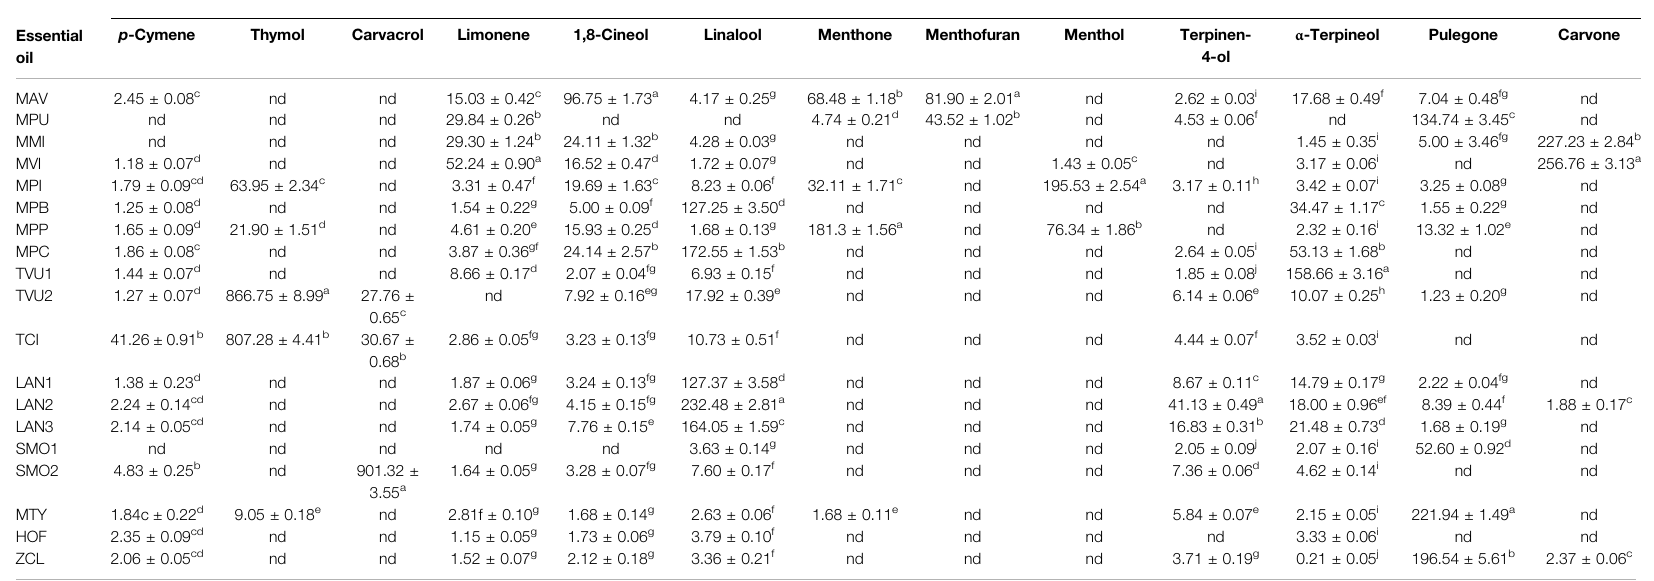
TABLE 1 | Concentrations of the main constituents of investigated essential oils.